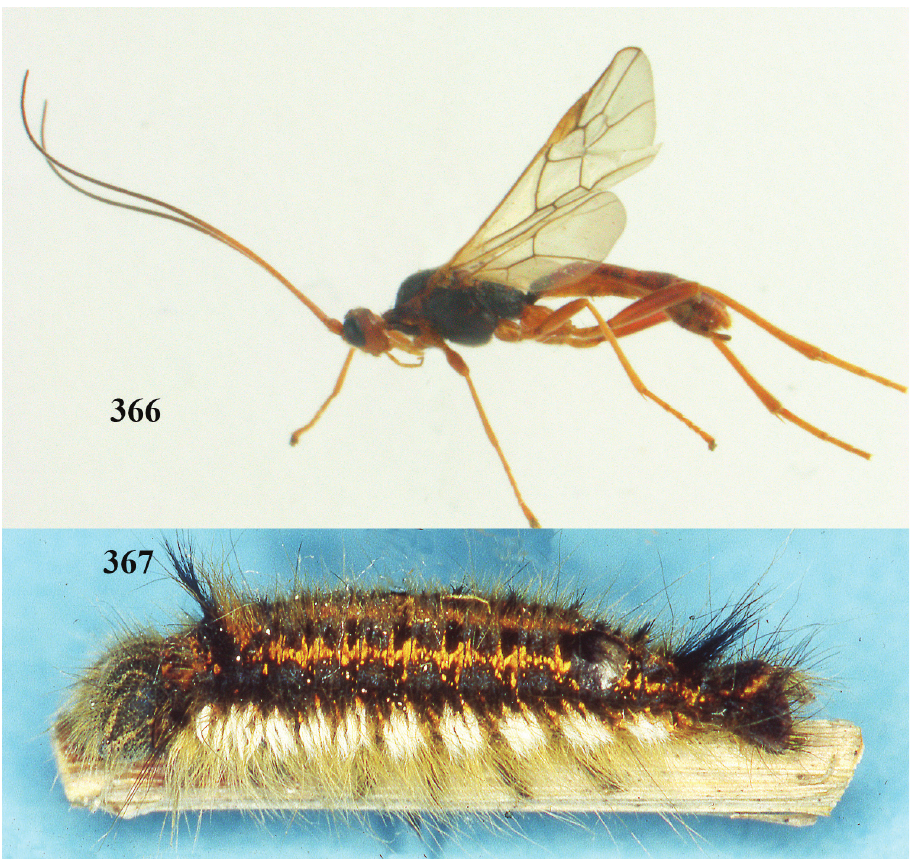
(Figs 375–376); clypeus partly above lower level of eyes (Fig. 374); length of malar space 0.6 × height of eye in lateral view; eyes distinctly protruding (Figs 374–376). Mesosoma. Mesoscutal lobes very finely coriaceous, with satin sheen, but medio- posteriorly with some rugae; notauli narrow, shallow and mainly coriaceous; prepectal carina rather lamelliform medio-ventrally, reaching anterior border of mesopleuron and latero-ventrally angulate; precoxal area of mesopleuron with some fine rugae me- dially (Fig. 369); mesopleuron above precoxal area (including hardly shiny speculum) superficially coriaceous, but dorsally coarsely rugose; medially metapleuron superfi- cially granulate, rather shiny; mesosternal sulcus narrow and rather deep, without ca- rina posteriorly; mesosternum angulate posteriorly; scutellum coriaceous-rugulose and carinate antero-laterally; dorsal face of propodeum rather long and densely moderately rugose, posterior face with some carinae and smooth in between, median carina com- plete, without tubercles, but somewhat angulate